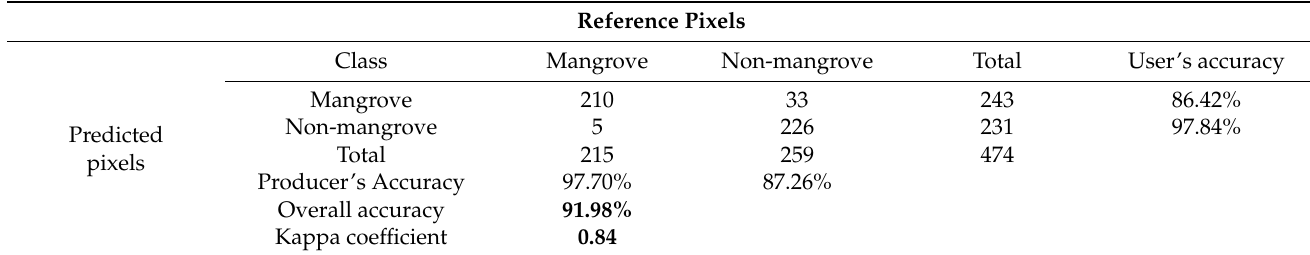
Table 3. The confusion matrix for accuracy assessment of mangrove forest using Landsat-9 OLI-2 in